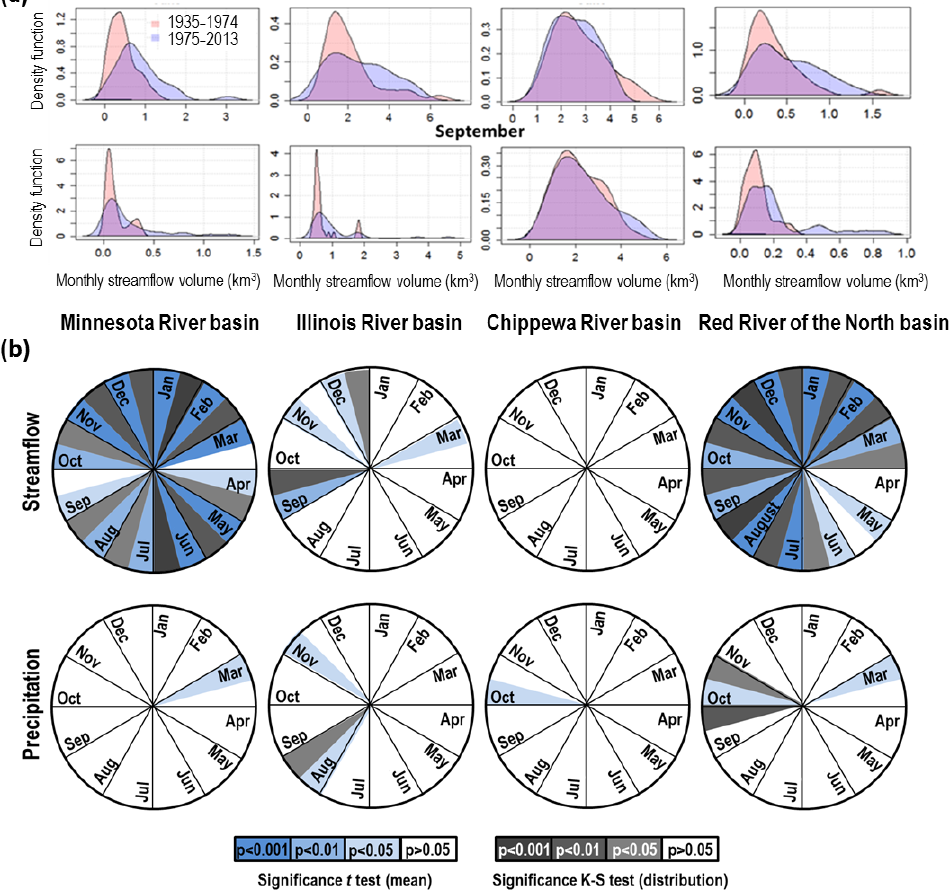
Figure 7. (a) Kernel density plots of monthly streamflow volumes for June and September for each basin. (b) Corresponding significance results for t tests and Kolmogorov–Smirnov (KS) tests ( α = 0.05) of monthly streamflow and precipitation volumes in each basin, where a significant result indicates a positive shift (increase) in the mean or distribution between 1935–1974 and 1975–2013; color wheels collectively display 192 individual p